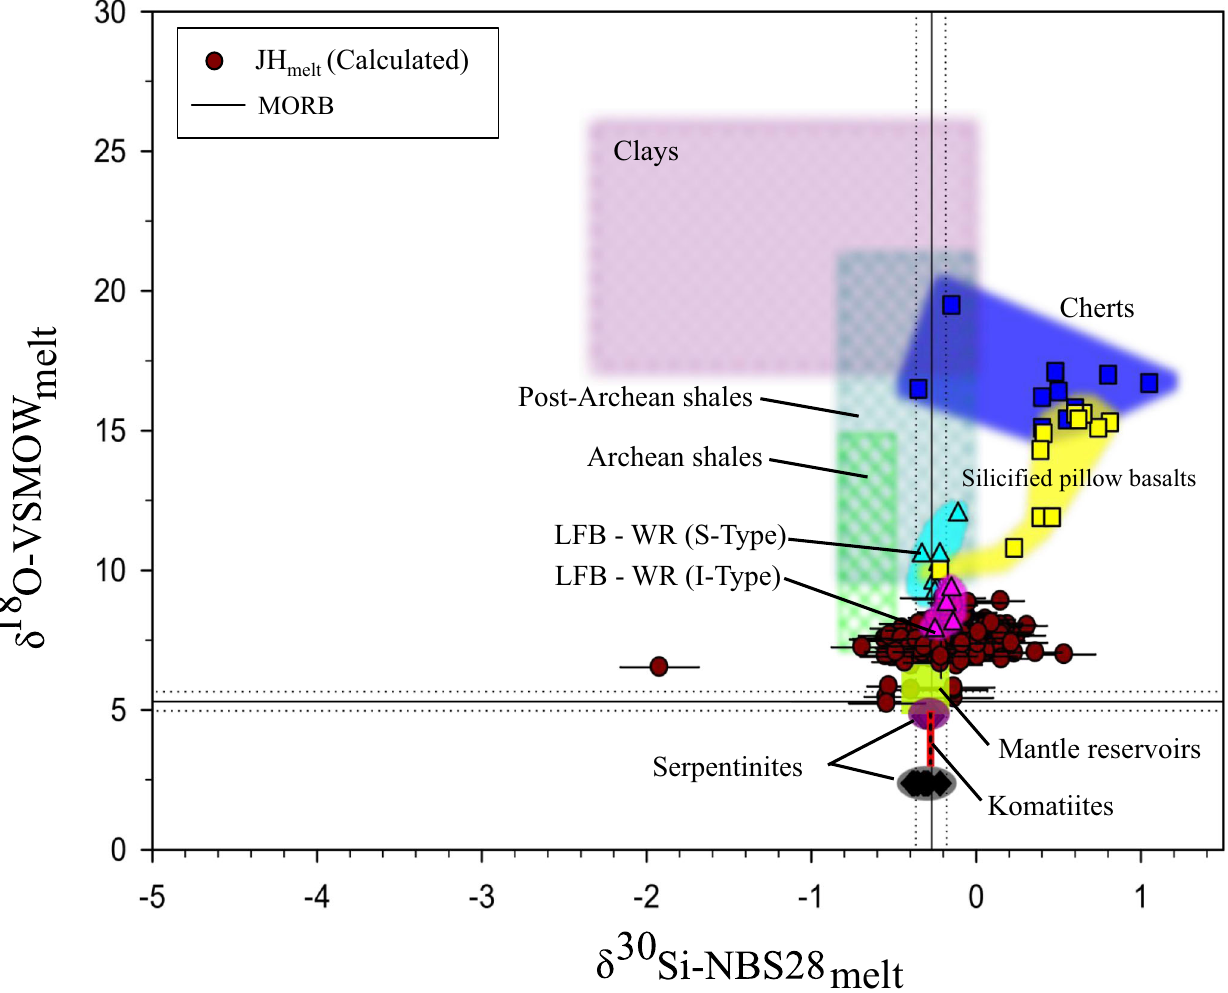
fi elds) ( δ 30 Si; 53 δ 18 O 54 ), Mantle reservoirs (lime green box) ( δ 30 Si of HIMU (Hi- μ ; Mangaia, Cook Islands), EM1 (Enriched Mantle 1; Pitcairn islands) and EM2 (Enri- ched Mantle 2; Samoa)) 55 ; δ 18 O of HIMU 56 (Olivine phenocrysts 57 , Δ 18 O melt-olivine 58 ), δ 18 O of EM1 and EM2 56 ) and Archaean komatiites (red bar) ( δ 30 Si: 26 , δ 18 O 59,60 ). JH δ 18 O, serpentinite error bars are smaller than the symbols. The assimilation/re- melting of these lithologies was also hinted at in just the JHZ (Jack Hills zircon) isotopic data (Supplementary Fig. 1). Data for MORB (Mid-Oceanic Ridge Basalt) is from ref. 61